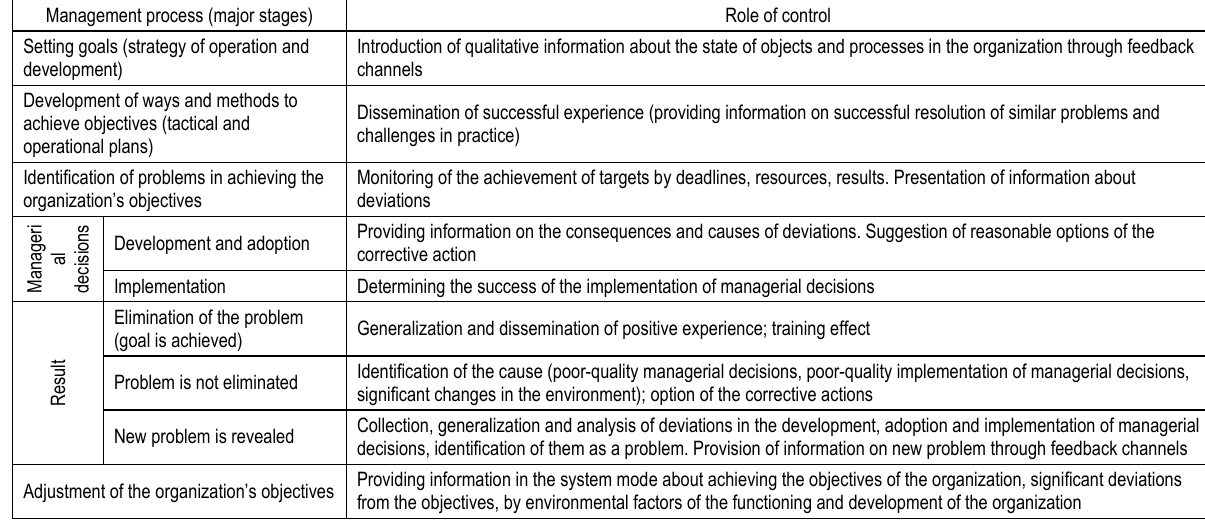
Table 3. Role of control in management